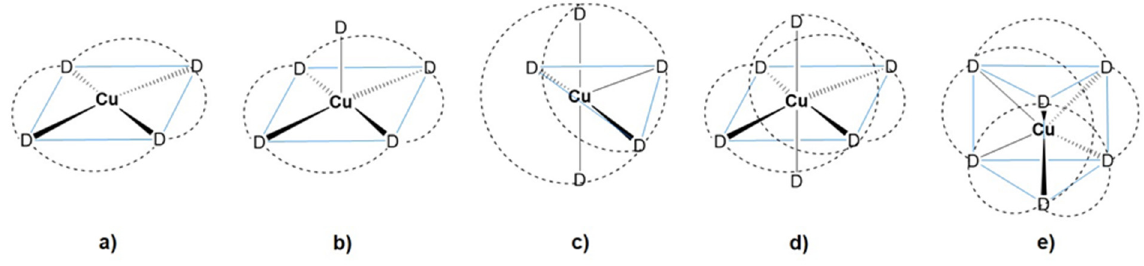
Figure 3. Complexation geometries of Cu(II) complexes: ( a ) square-planar, ( b ) square-pyramidal, ( c ) trigonal-bipyramidal, ( d ) octahedral and ( e ) trigonal-prismatic.